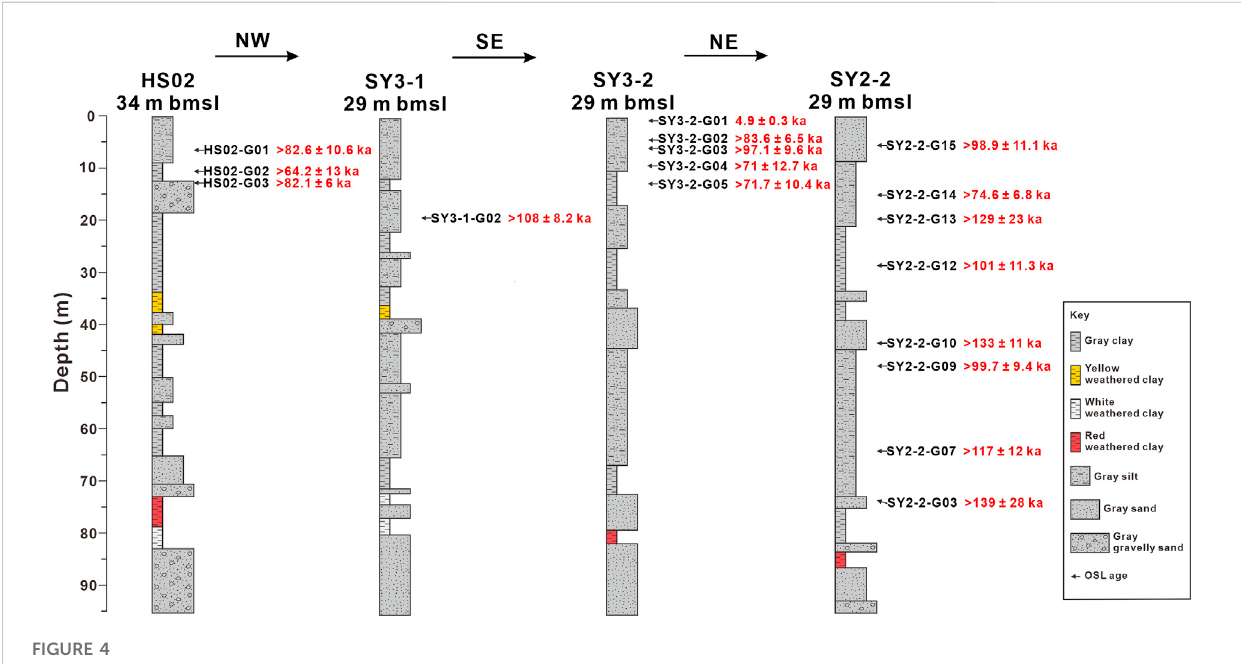
FIGURE 4 Pro fi les and OSL ages of cores HS02, SY3-1, SY3-2, and SY2-2.